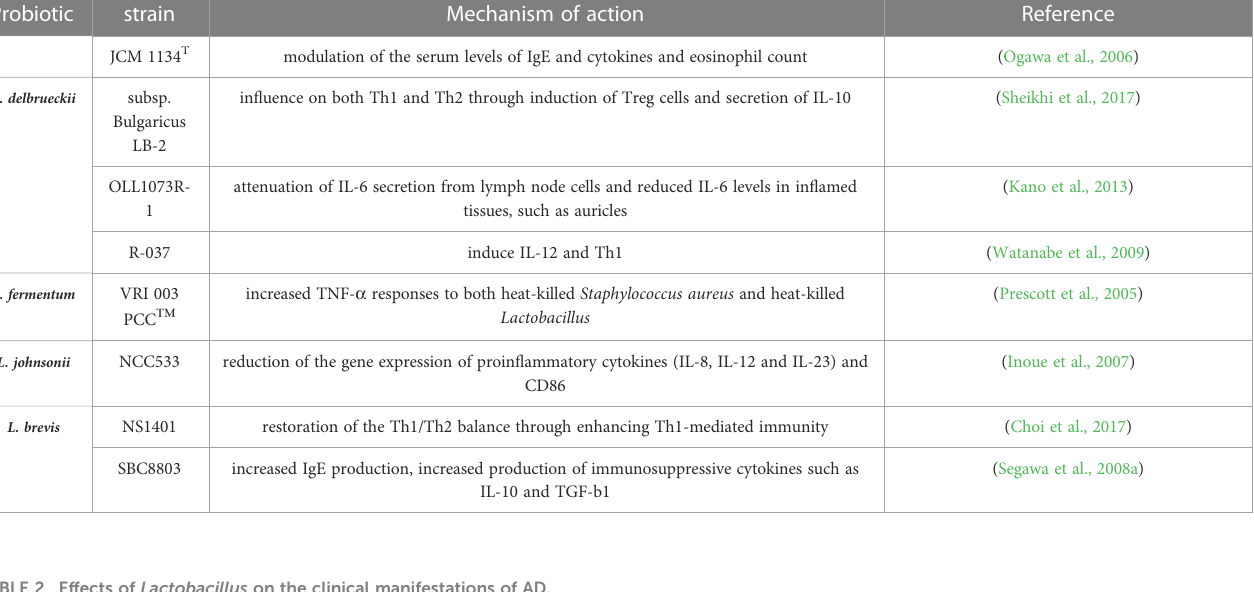
TABLE 2 Effects of Lactobacillus on the clinical manifestations of AD.